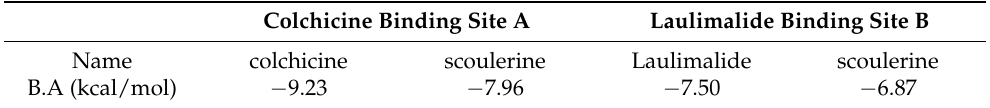
Table 3. A—Binding energies of scoulerine and colchicine docked in the colchicine binding site (1SA0). B—scoulerine and laulimalide docked in the laulimalide binding site (4O4H). Colchicine Binding Site